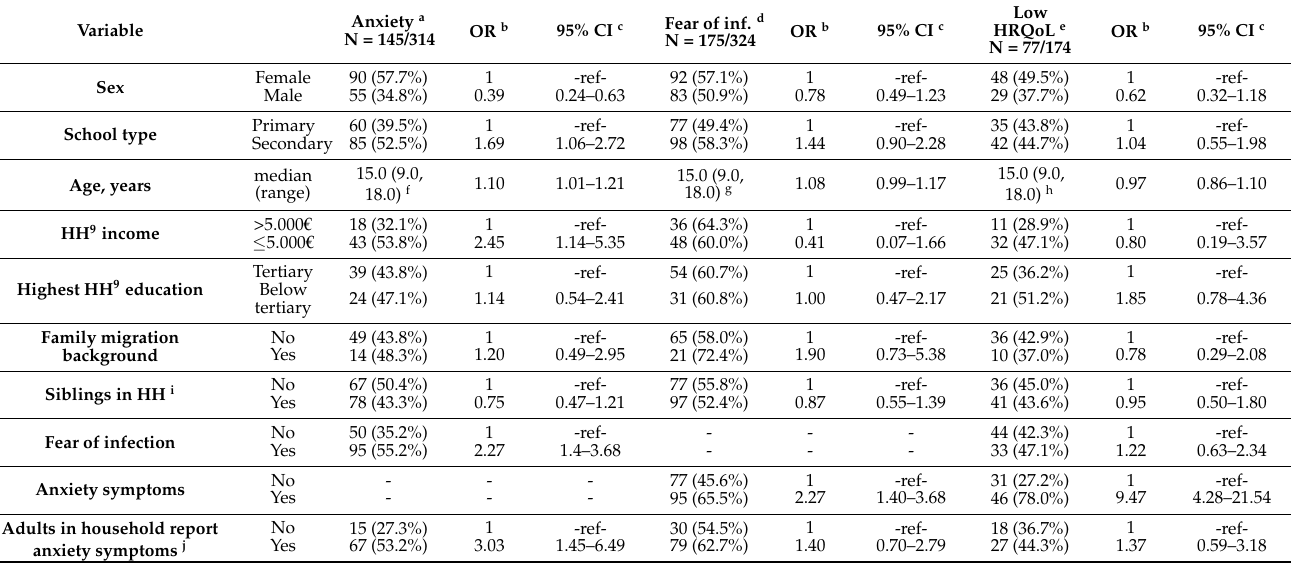
Table 2. Factors associated with anxiety, fear of infection and low HRQoL among Berlin